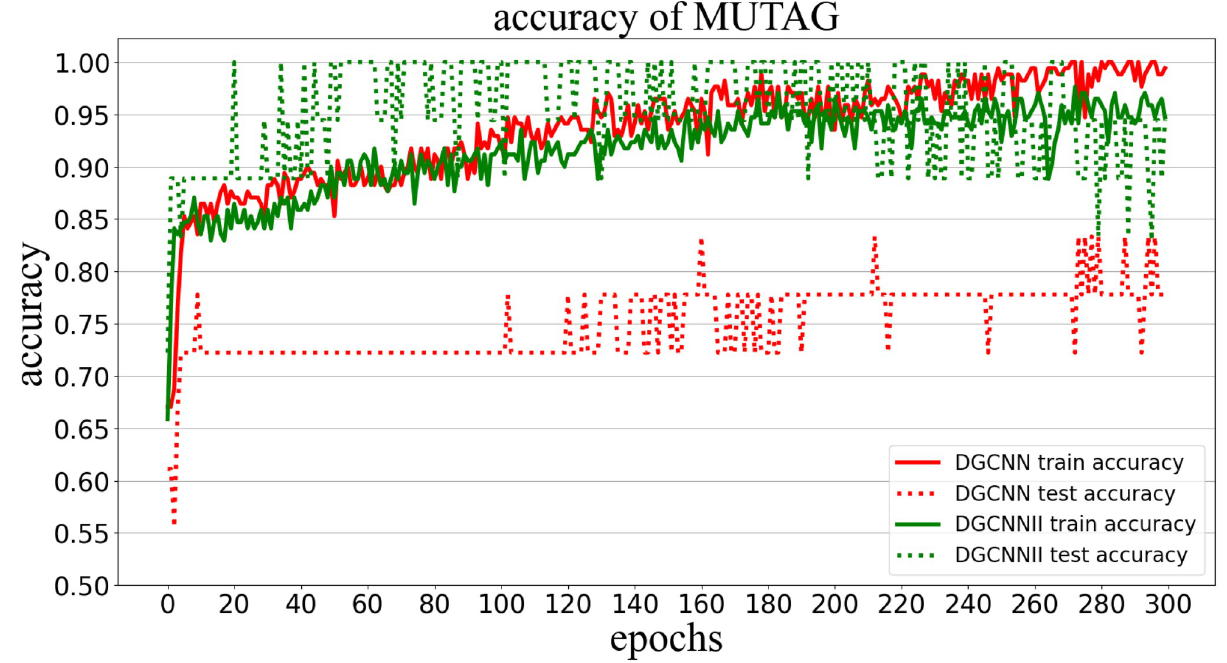
Fig 5. Comparison of graph classification accuracy between DGCNNII and DGCNN on MUTAG dataset.